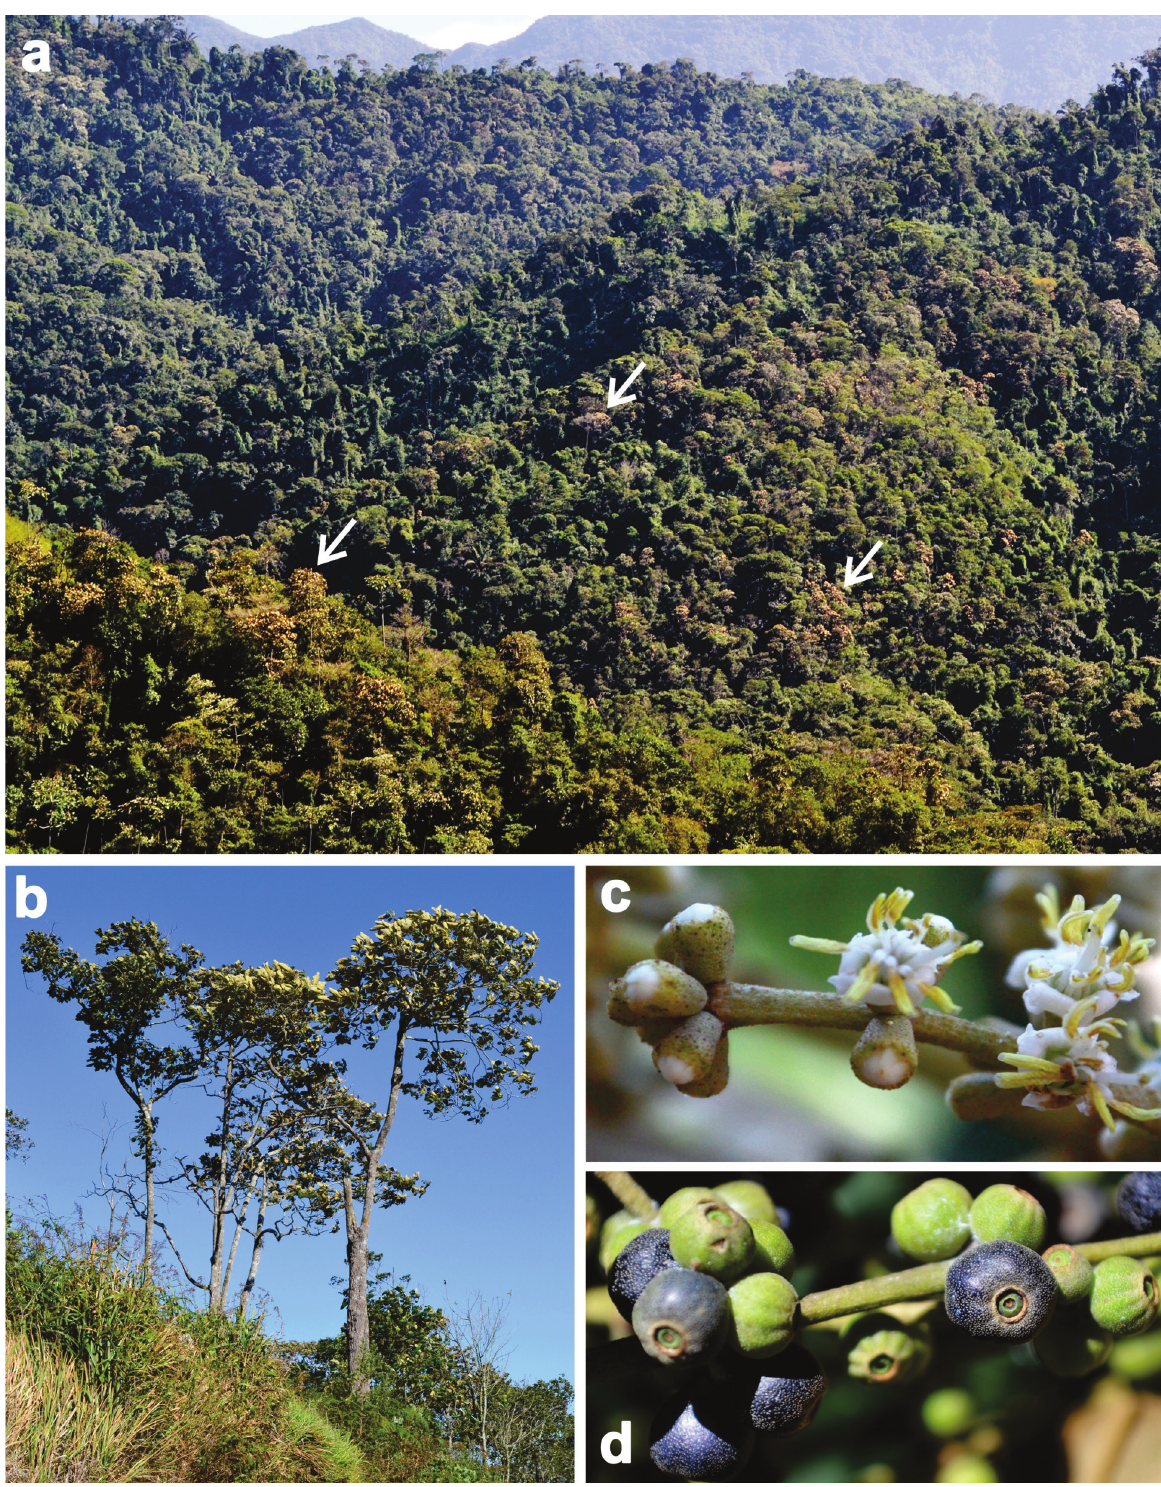
Figure 2 - a. individuals of Miconia gigantea Cogn. (arrows) in Dense Ombrophilous Forest of the Cunhambebe State Park, Rio de Janeiro, Brazil, which are distinguished by the color of the adaxial surface of the leaves. b. remnant individuals of M. gigantea in a pasture area. c. detail of buds and flowers. d. details of young (green) and mature (purple-black)